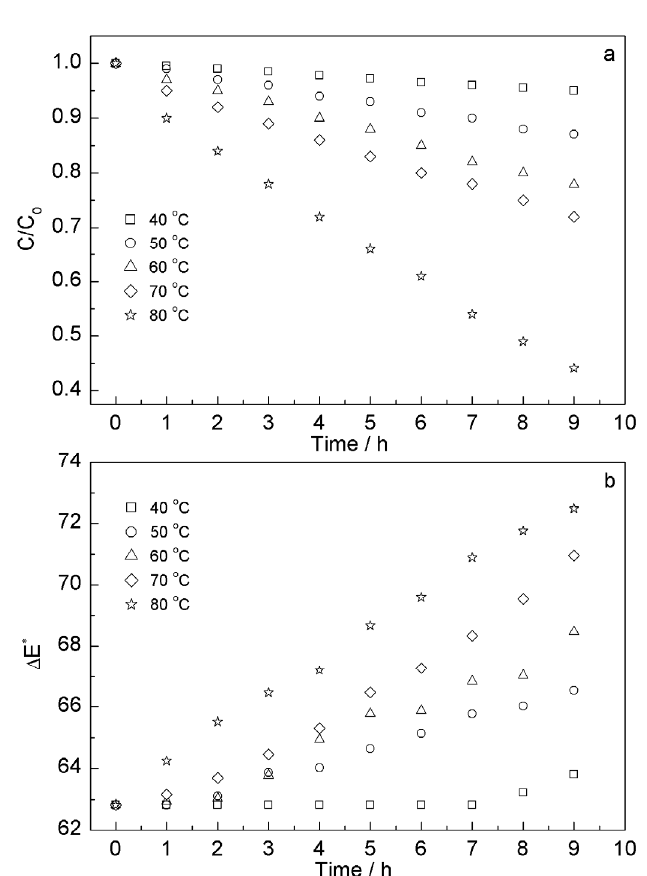
Figure 3. Effect of heating on content ( a ) and color ( b ) stability of S. chinensis fruit